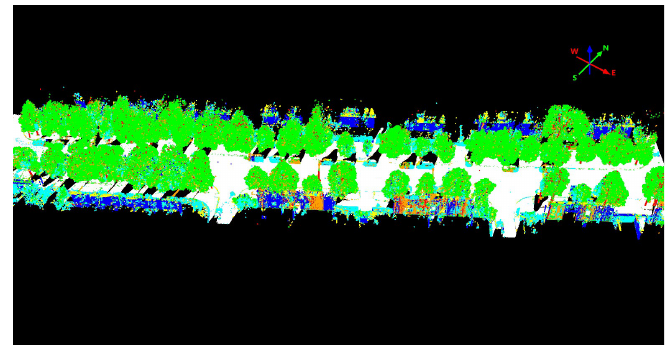
Figure 3. An illustration of result of RF classification